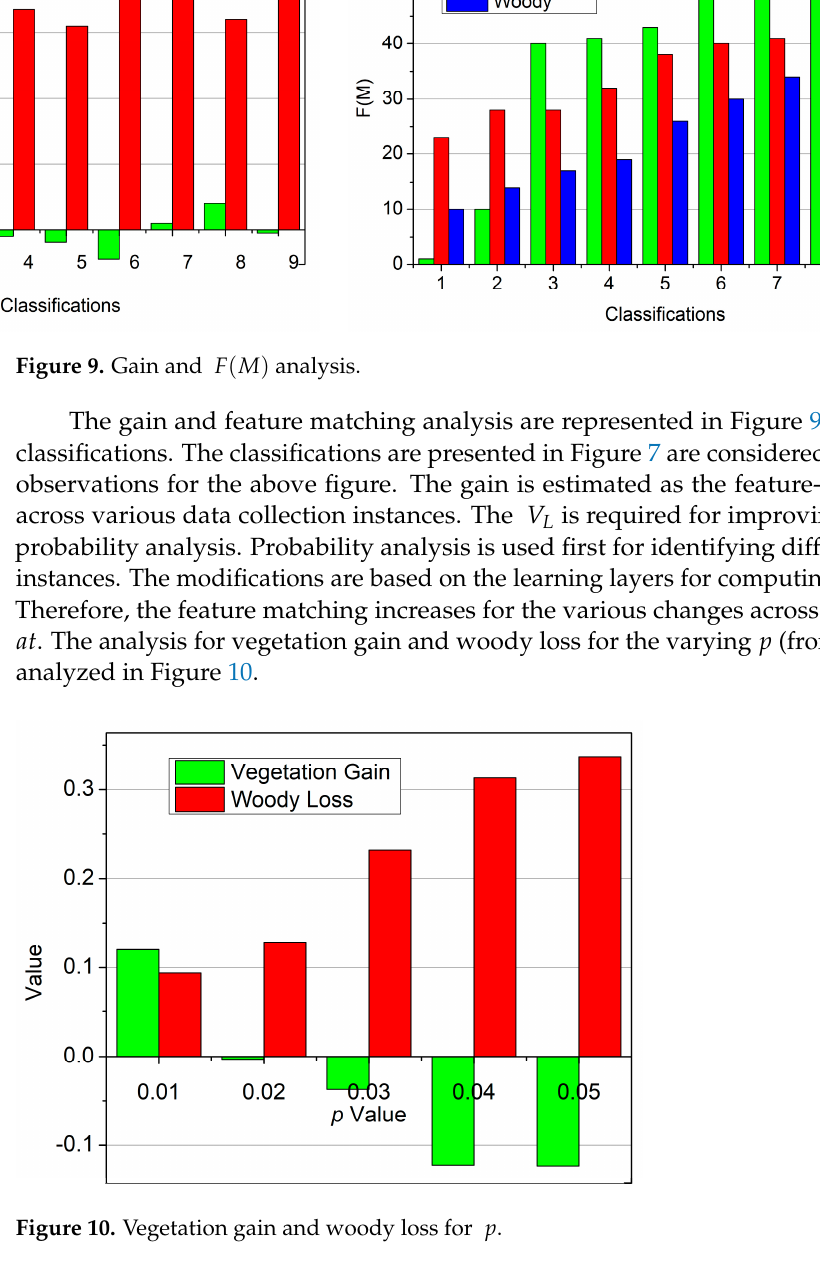
Figure 10. Vegetation gain and woody loss for 𝑝 .